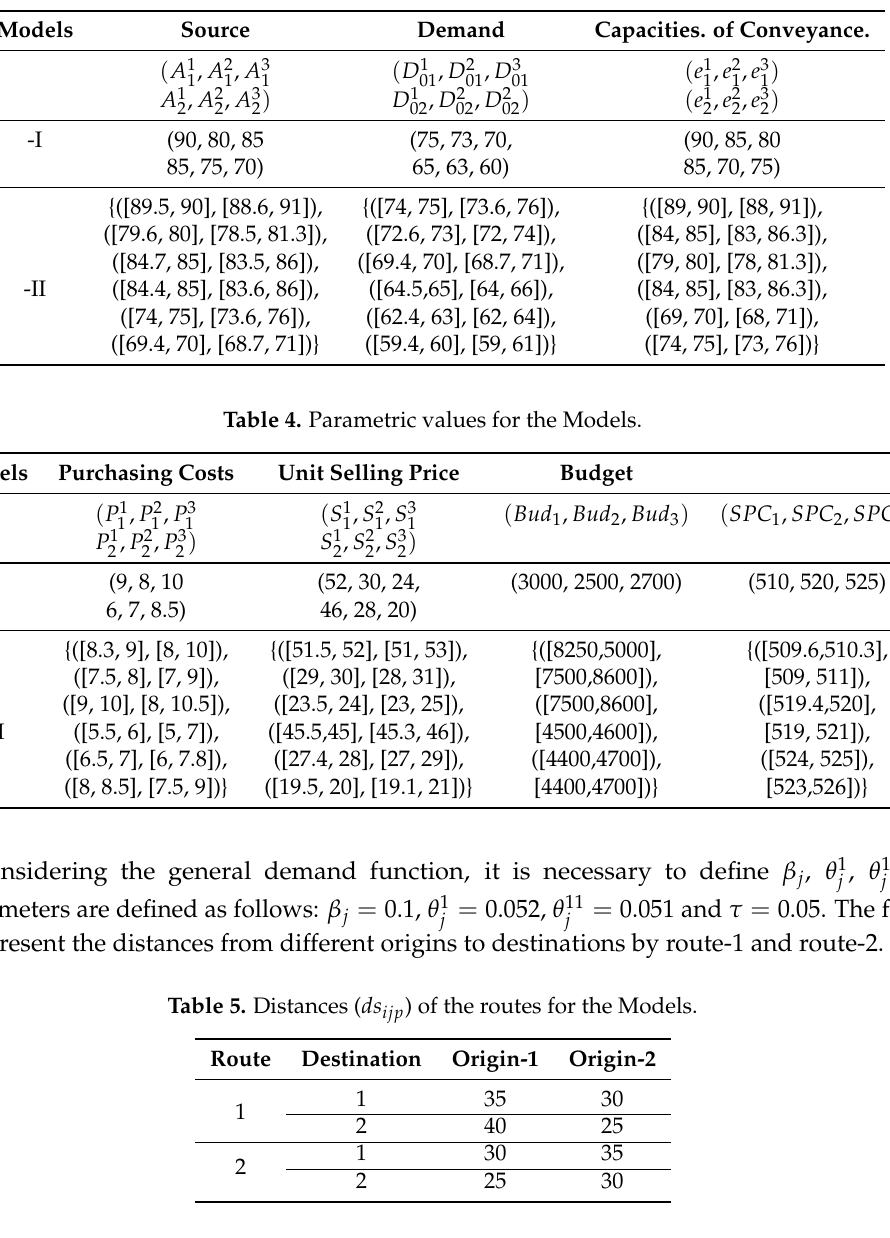
Table 3. Parametric values for the Models.